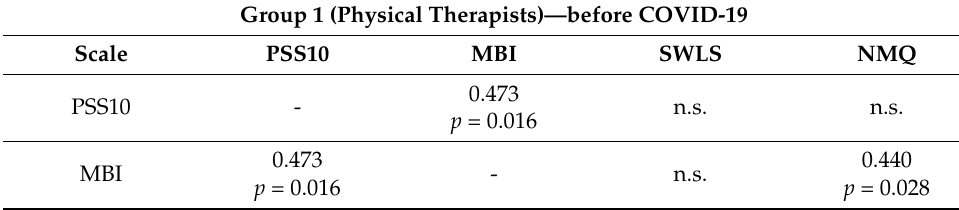
Table 6. Correlations between test